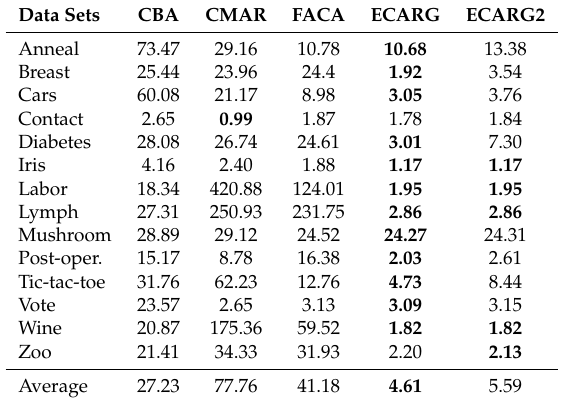
Table 13. The classifier building memory consumption in megabytes.